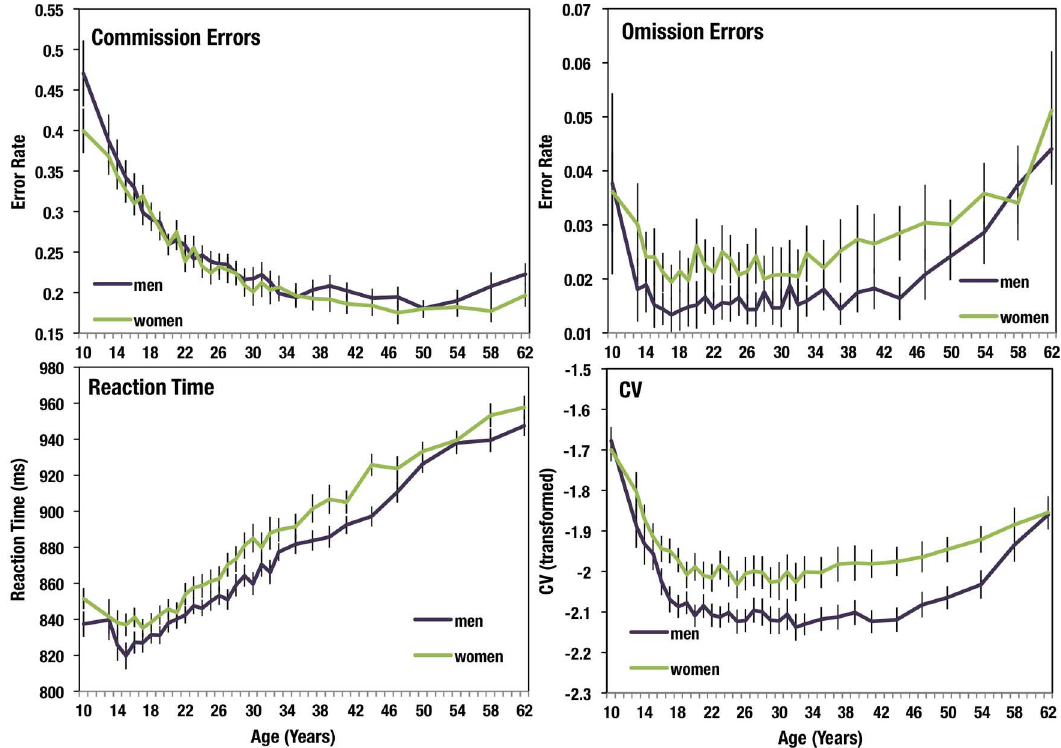
Fig 1. Gender differences in each of the four gradCPT variables across the lifespan. Error bars show 95% confidence interval, N = 11,612 men and 9,872 women, N > 40 in each age bin.